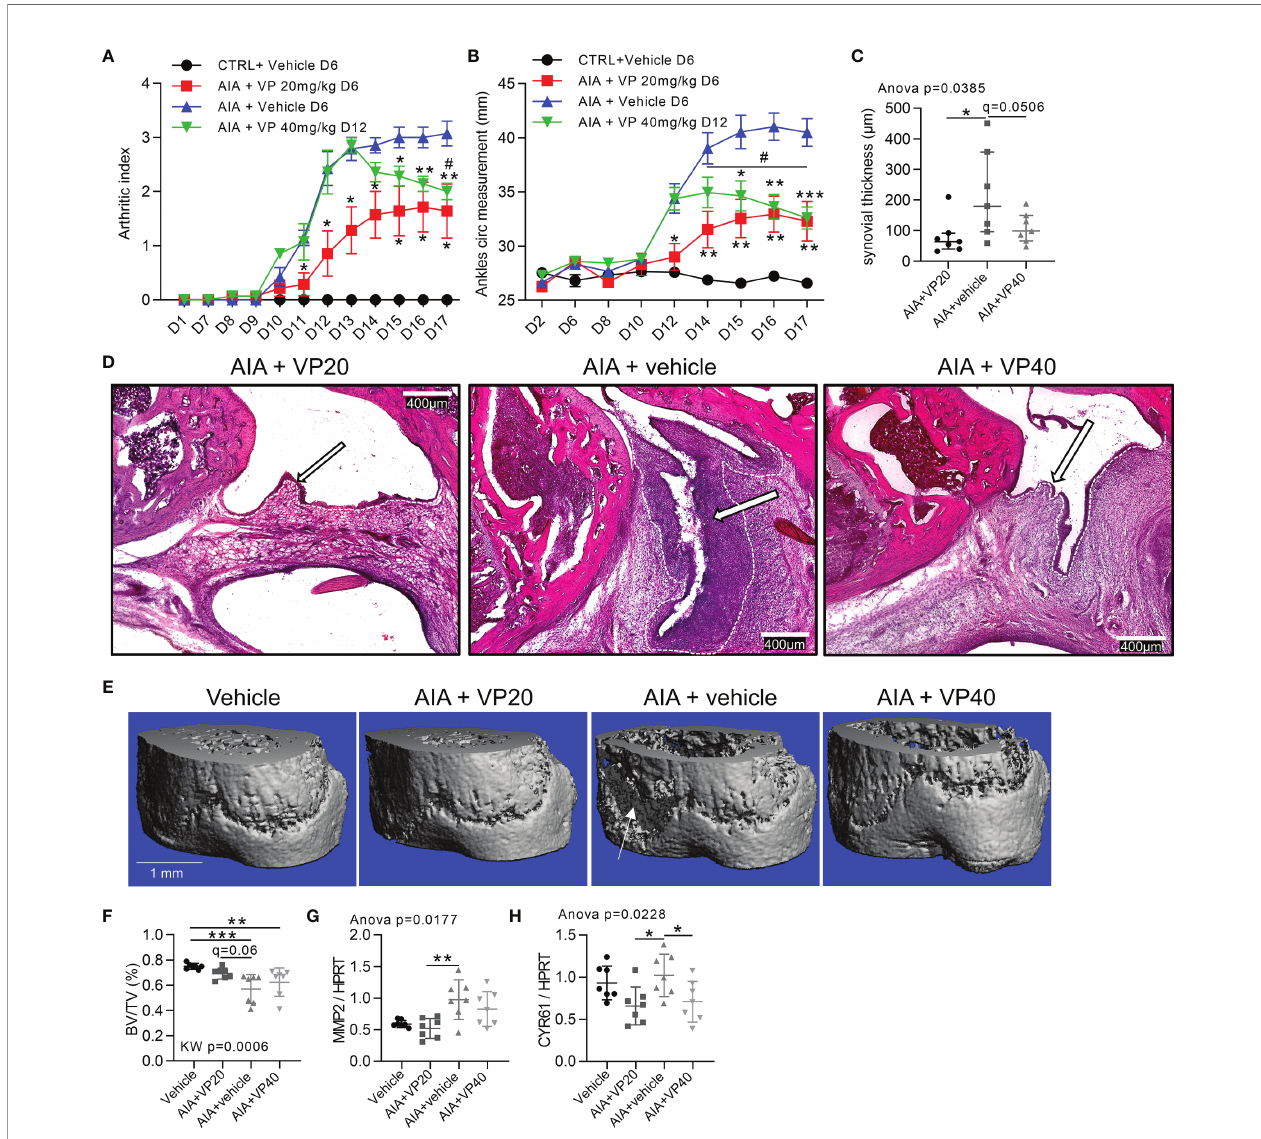
FIGURE 5 | Prevention and reduction of arthritis severity in rat AIA model by YAP inhibition. Day 0 corresponded to AIA induction. Control or arthritic (AIA) rats were IP injected with vehicle containing 10% DMSO, treated AIA rats received 20 µg/kg/day of VP from day 6 (VP20) as a preventive approach or 40 µg/kg/day VP from day 12 (VP40) as a curative approach. (A, B) Arthritic index and ankles circumference measurements. Two-way ANOVA with FDR post hoc test corrected for multiple comparison (*), and paired t-test between days 14 and 17 (#) for VP40 group. (C, D) Quanti fi cation of synovial hyperplasia (C) with representative tiles images at x100 magni fi cation (D) , H&E staining; arrows: synovial lining layer; dotted lines: limit between synovial lining layer and synovial stroma. (E, F) Representative 3-D reconstruction of micro-computed tomography scan for distal tibia epiphysis (E) with corresponding quanti fi cation (F) of BV/TV (bone volume/tissue volume); arrow: bone erosion. G-H: RT-qPCR quanti fi cation of MMP2 (G) and CYR61 (H) expression normalized to HPRT expression. Data were presented as individual values with mean ± SEM (A, B) or mean ± SD (C, F – H) . Kruskal Wallis (F) or ANOVA test with FDR post hoc test corrected (q-value) for multiple comparisons. * or # q < 0.05; **q < 0.01; ***q <